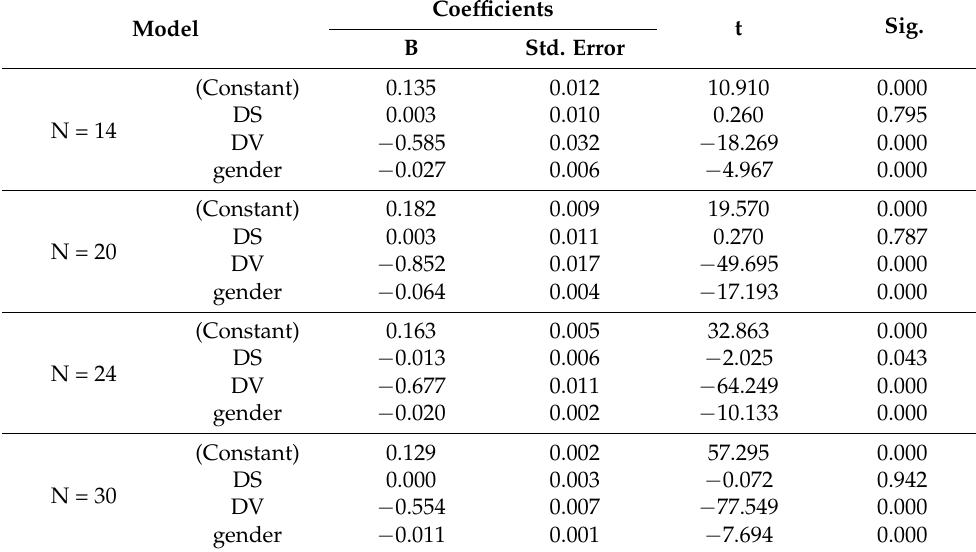
Table 4. Coefficients in the multiple regression models for